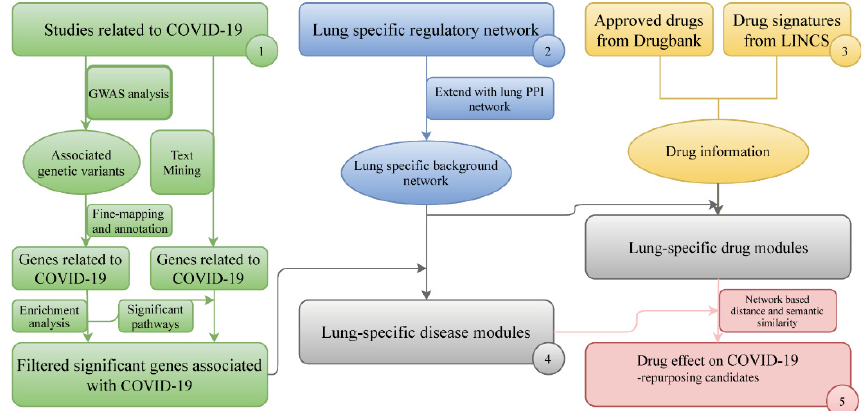
Figure 1. Schematic illustration of the computational procedure. Step 1: Significant COVID-19-associated genes are identified by combining the GWAS results and literature findings, followed by a filtering step based on the gene set enrichment analysis. Step 2: A lung-specific background molecular network is constructed by integrating lung-specific transcriptional regulatory and PPI networks. Step 3: The drug information is downloaded from the DrugBank and LINCS databases. Step 4: COVID-19-related gene modules and drug-related gene modules are established using the net- work analysis. Step 5: To measure the drug effects, a proximity score between the drug- and COVID- 19-related gene modules is computed based on the network distance and semantic similarity.